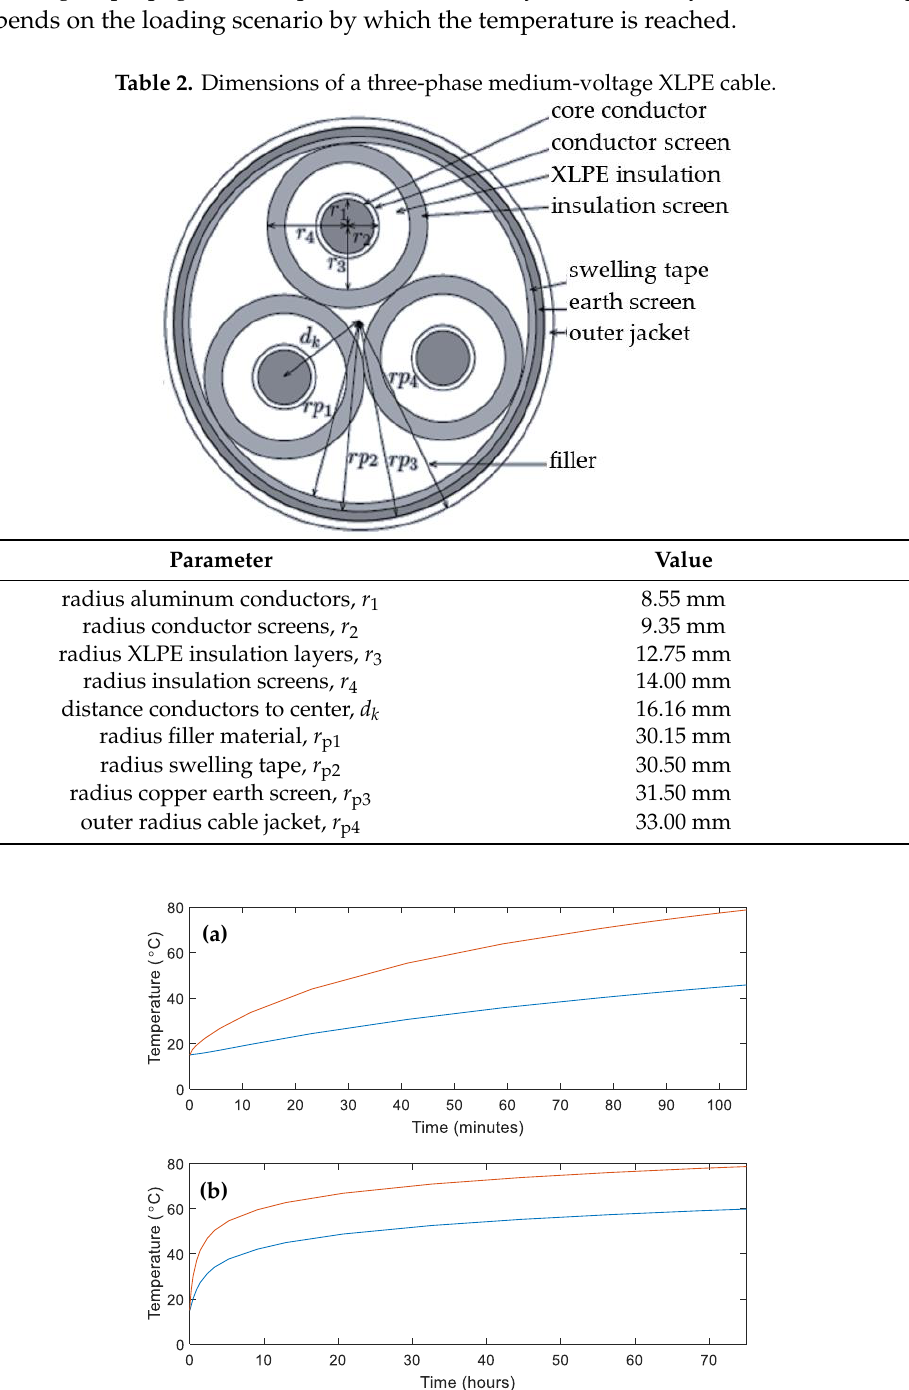
Figure 4. Simulated conductor temperature (red) and earth screen temperature (blue) for cable with 1¾ times ( a ) and 1¼ ( b ) times nominal current; initial (ambient) temperature is 15 °C and the simulation is continued until a conductor temperature of around 80 °C is reached.